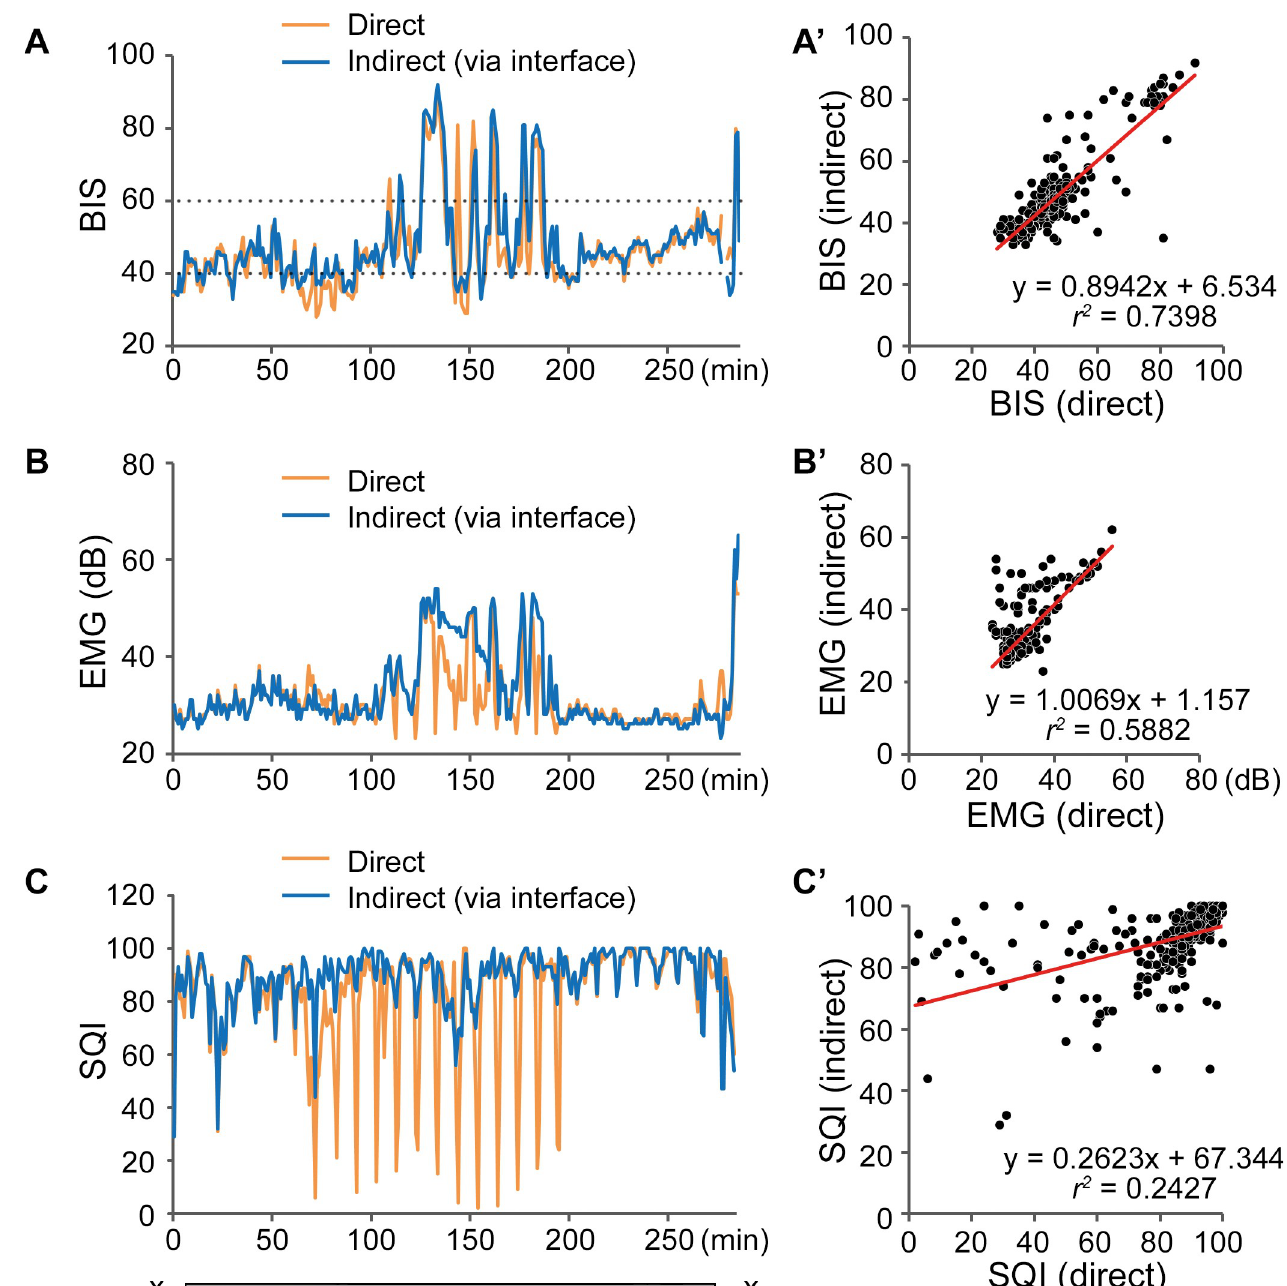
Fig 6. An example of unstable BIS. (A-C) Representative BIS (A), EMG (B), and SQI (C) curves from a single patient with an artefact noise in EMG. Curves from direct recording (orange lines) and indirect recording (blue lines) are superimposed. A’-C’ panels designate correlation analyses for BIS, EMG, and SQI, respectively. Due to stimulation of orbicularis oculi muscle, EMG was strongly disturbed (B), and the impedance check strongly affected SQI of direct recording during the orbicularis oculi muscle stimulation (C). Nevertheless, the effect on the BIS agreement was minimal (A’). The period between X: Anesthesia induction until recovery; grey bar: Intubated period; black bar: Surgical procedure period; BIS: bispectral index, EMG: electromyogram, SQI: signal quality index.